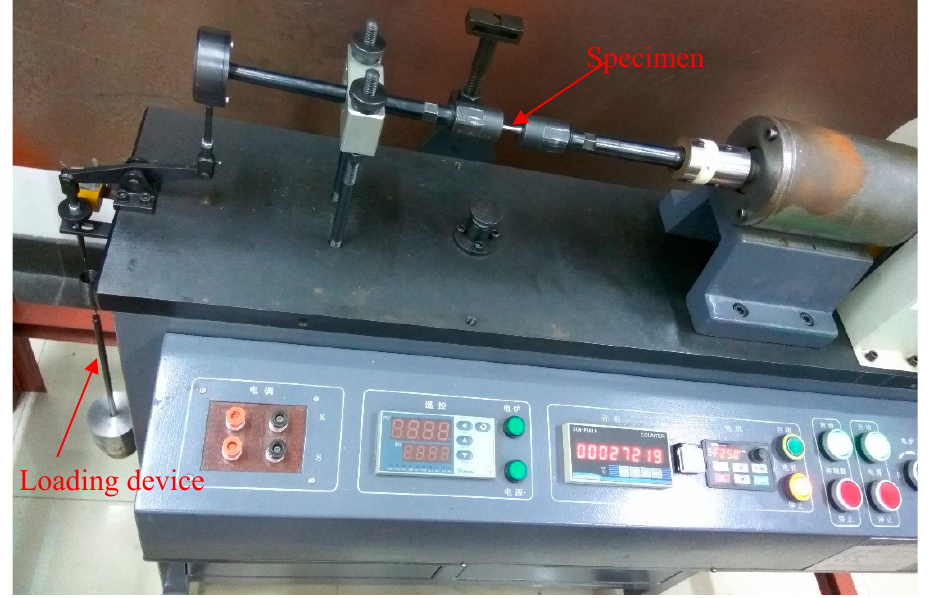
Figure 2. The testing apparatus.